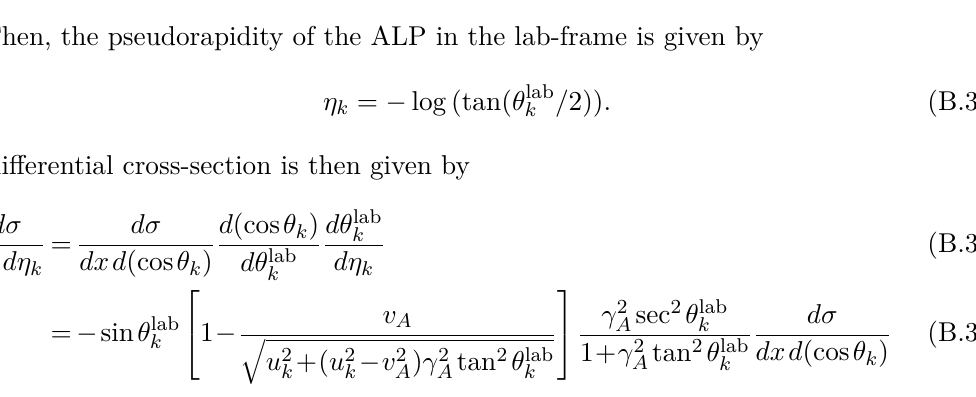
Figure 4 . The differential cross section for the process eA Z → τA Z a as a function of the energy fraction x = E k /p for m a = 0 . 1 , 2 . 0 , 10 . 0 , and 20 . 0 GeV, assuming an interaction strength | C τe | / Λ = 1 TeV − 1